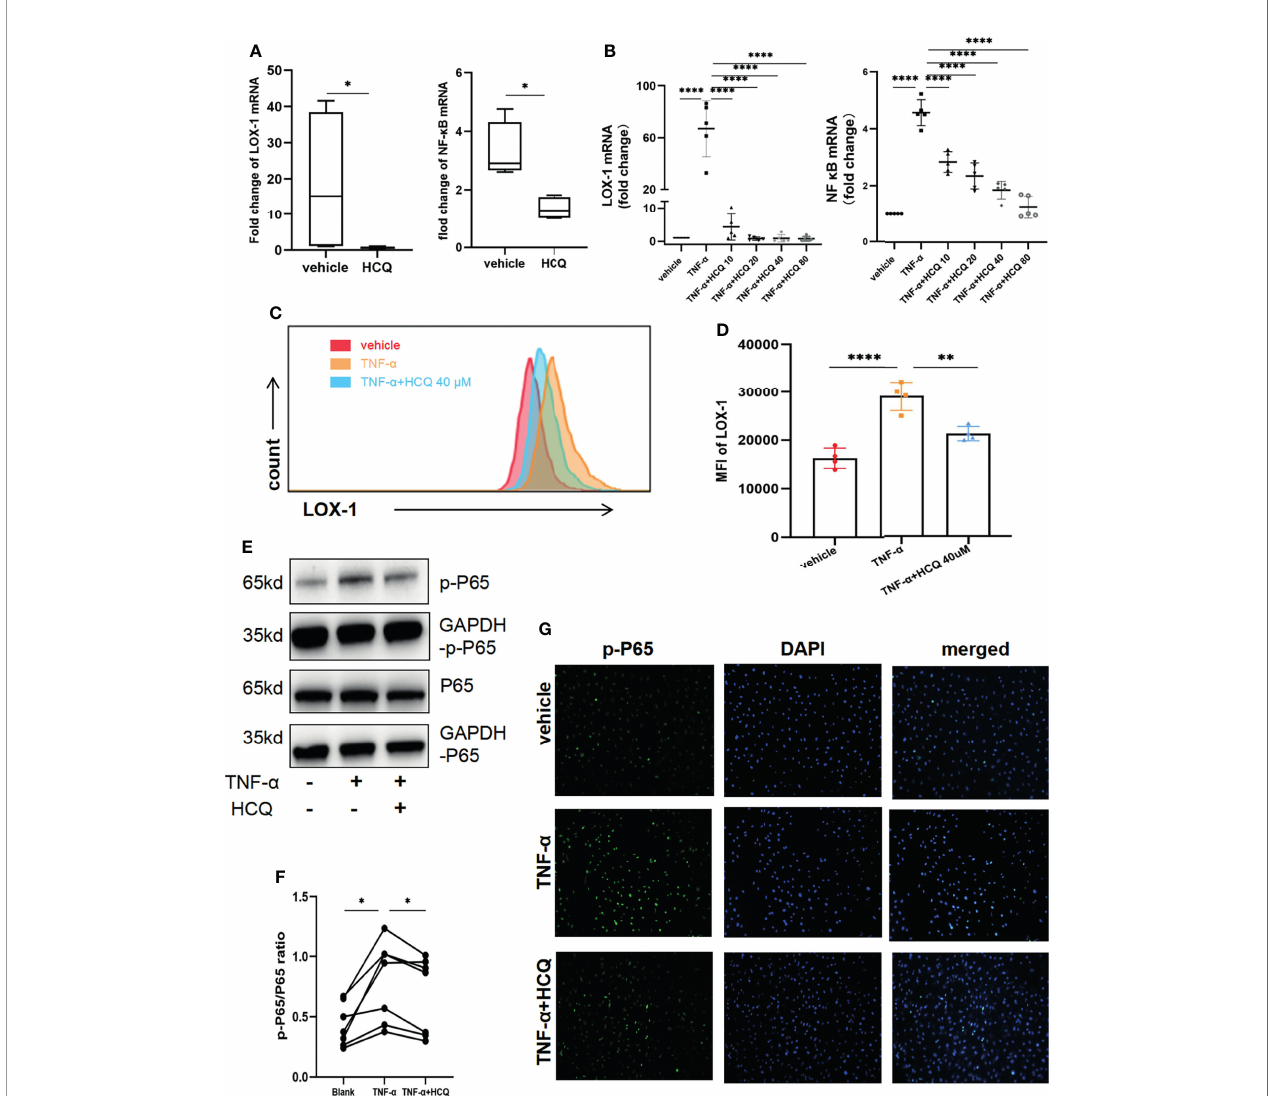
FIGURE 5 | Hydroxychloroquine (HCQ) regulates TNF- a – stimulated endothelial dysfunction via the LOX-1/NF- k B axis. (A) In the in vivo study, RT-qPCR results showed that HCQ suppressed the LOX-1 and NF- k B mRNA expression in retinal tissue of experimental autoimmune uveitis (EAU) mice (N = 4). (B) In the in vitro studies, RT-qPCR revealed that HCQ (10, 20, 40, and 80 µM) considerably and dose-dependently decreased LOX-1 and NF- k B mRNA expression in the retinal vascular endothelial cell (RVEC) dysfunction model. Furthermore, we veri fi ed these results at the protein level (N = 5). (C, D) Flow cytometry analysis showed that the mean fl uorescence intensity (MFI) of LOX-1 in TNF- a – stimulated RVECs was higher than that in the vehicle group. HCQ reduced its MFI at a concentration of 40 µM with a signi fi cant difference(N = 4). (E, F) Western blot analysis showed upregulated expression of total p65 (t-p65) and phosphorylated p65 (p-p65) in TNF- a – stimulated RVECs compared with those in the vehicle group. HCQ (40 µM) treatment suppressed their expression and lowered the p-p65/t-p65 ratio (N = 7). (G) Immuno fl uorescent staining showed colocalization of p-p65 (green) and the nuclei (blue) of RVECs. Elevated expression of p-p65 was observed in RVECs after TNF- a stimulation, whereas HCQ treatment reduced the expression of p-p65 in RVECs. The data are presented as the mean ± SD (*P < 0.05, **P < 0.01, ****P <